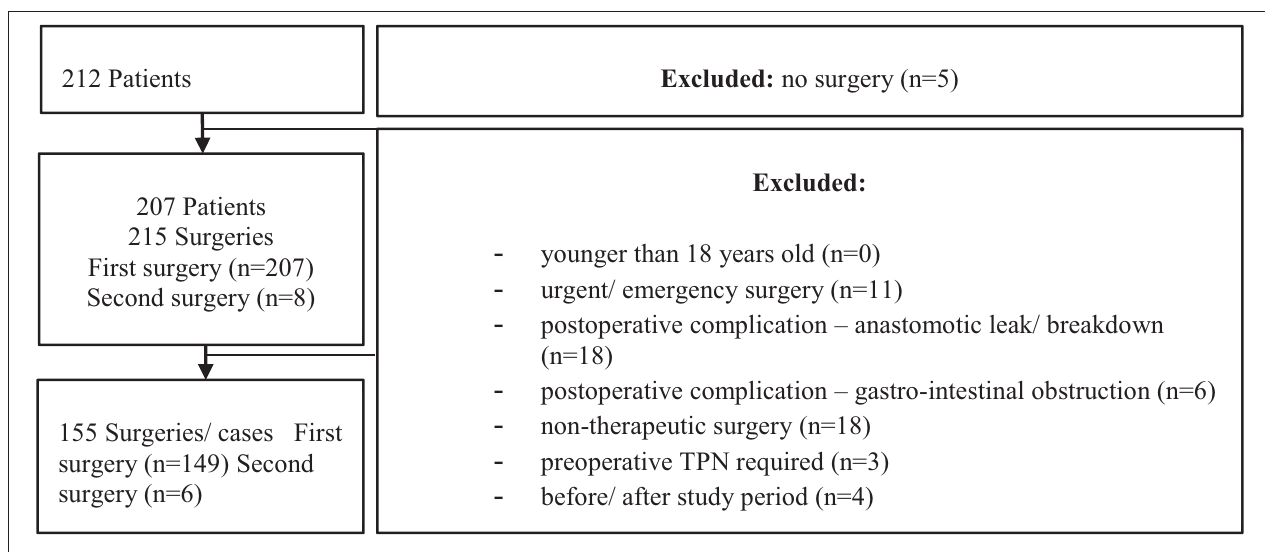
FIGURE 1 | Exclusions made from REDCap